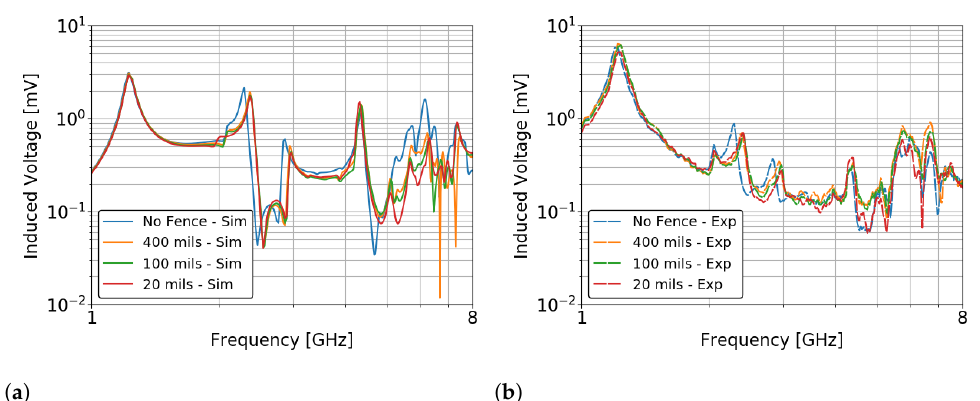
Figure 12. Comparison of simulated vs. experimentally measured induced voltage for a plane wave propagating in the negative z direction (Case 1 ): ( a ) simulation and ( b ) experimental. The exper- imental data deviate slightly from the simulation data but similarly demonstrate that via fencing density does not dramatically affect